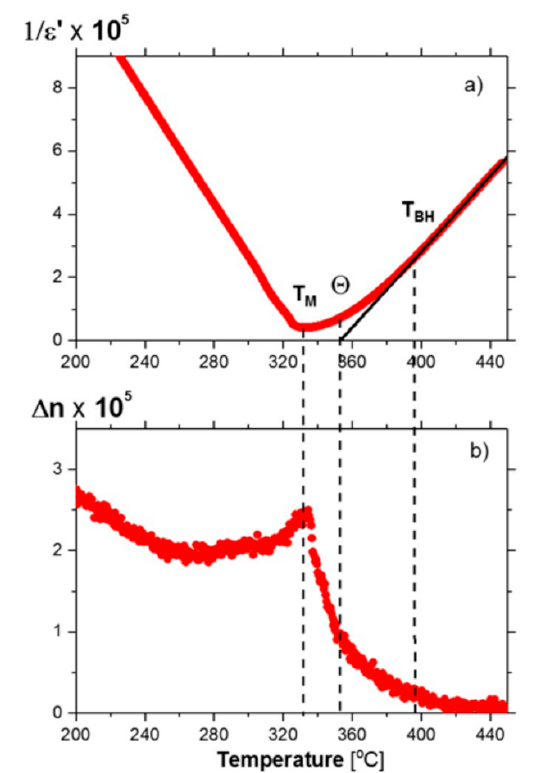
Figure 13. Changes in the inverse of permittivity and birefringence (average value) as a function of temperature for PZT 70 / 30 ceramics doped with 0.2 mol% Bi 2 O 3 , obtained on heating. ( a ) Inverse permittivity showing temperature T M , Curie–Weiss temperature θ , as determined from ε − 1 (T) run, and temperature T BH calculated from the formula T BH = 1.1 T M ; ( b ) temperature changes of birefringence determined from the area of 500 × 450 μ m 2 of ceramics with 65 μ m thickness [38].